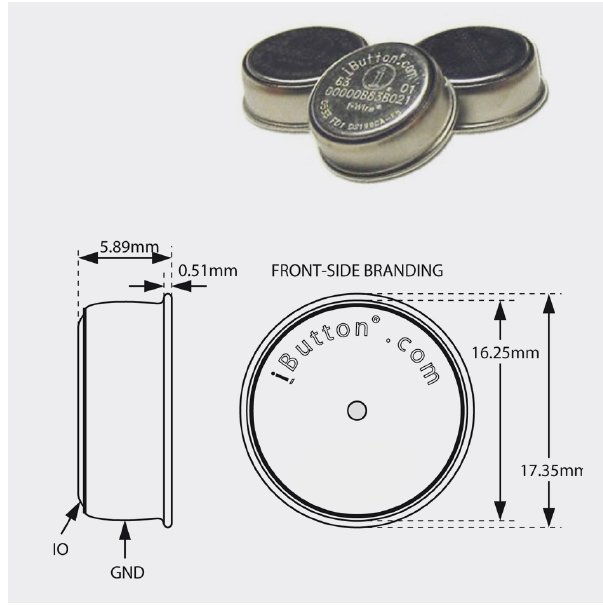
r DS1922L that was used for temperature